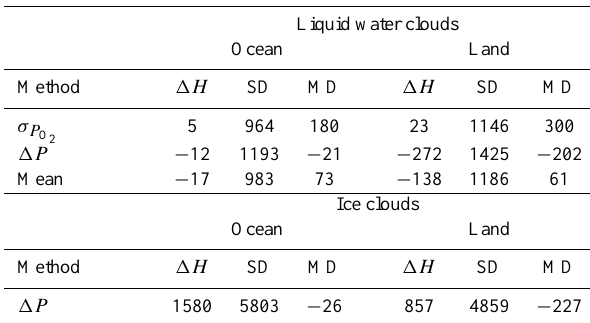
Table 2. Statistics of the retrieval of cloud geometrical H 2 thickness for liquid water and ice clouds in 2008 over ocean and land. 1H = H retrieved − H for the different methods of retrieval. SD (MD) stands for standard deviation (median). All values are in meters.